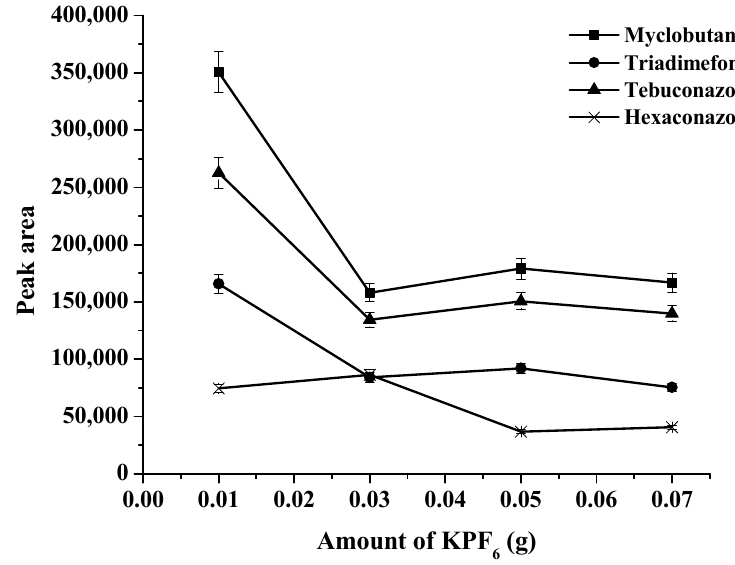
Figure 3. Effects of the amount of KPF 6 on the extraction efficiency.